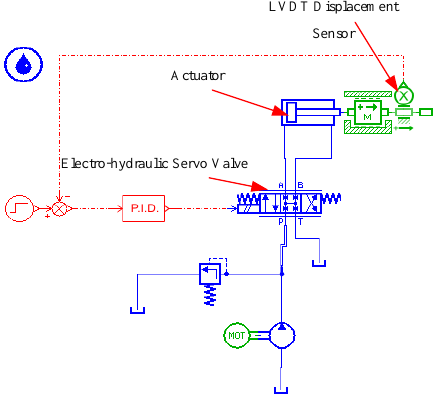
Figure 12. Fuel Metering Model in AMESim.